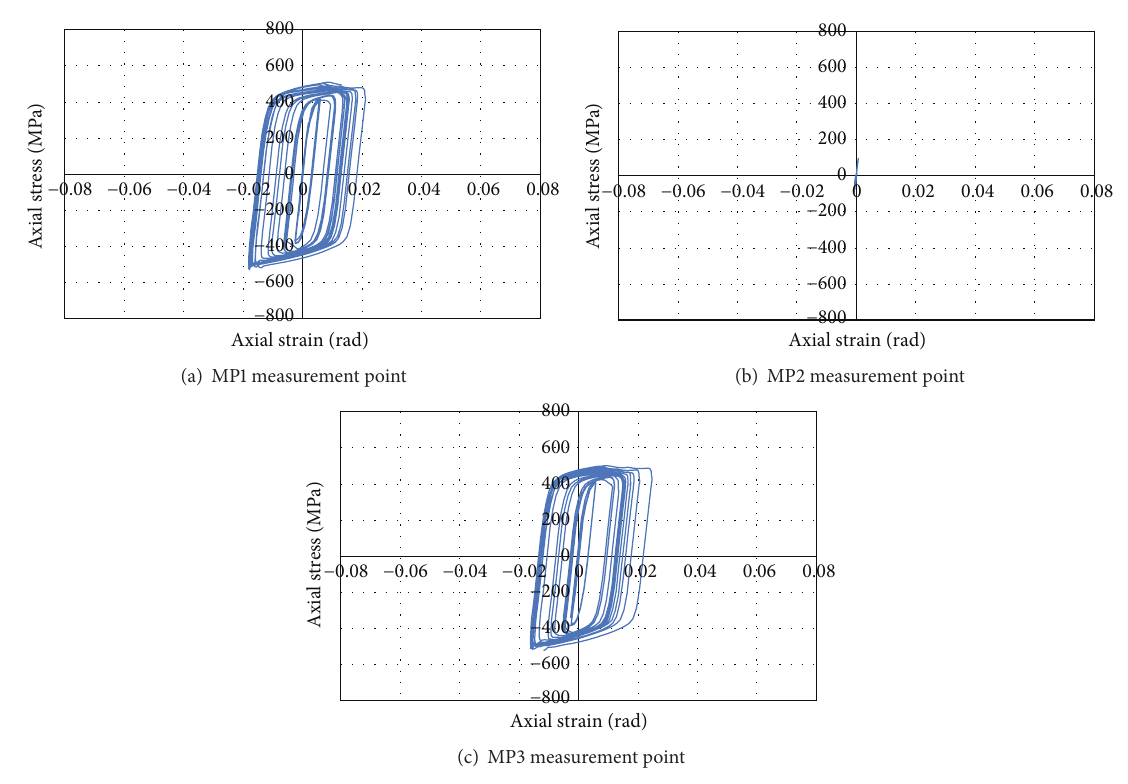
Figure 18: True stress and strain curves obtained from individual measurement points (STE-0.10